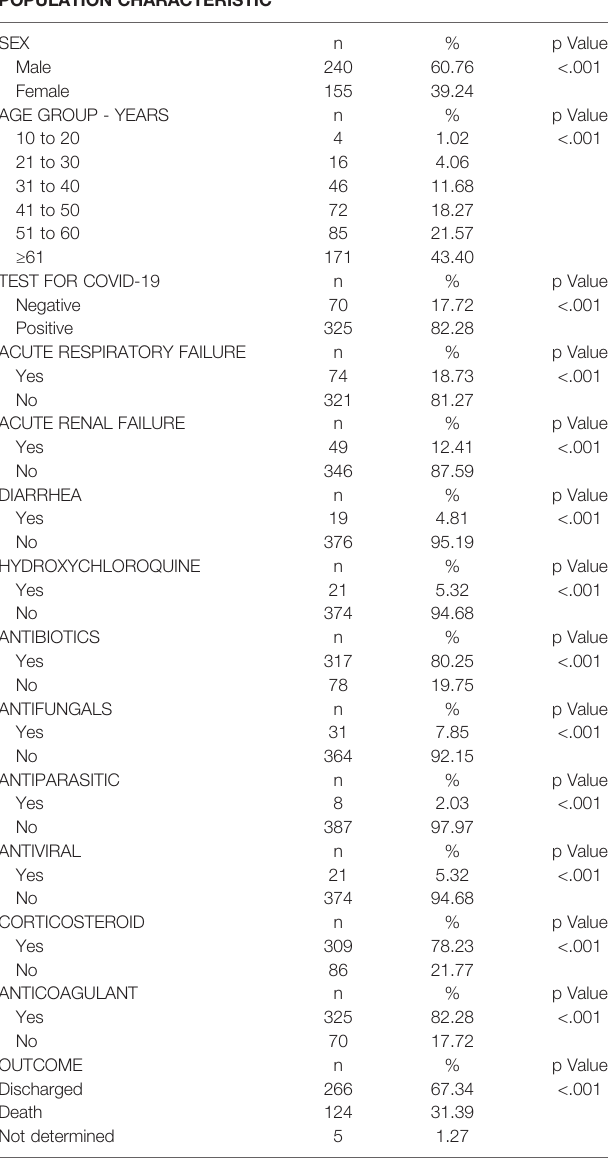
TABLE 2 | Distribution of hospitalized patients with a suspected COVID-19 diagnosis in the macroregion of the Tria ̂ ngulo Mineiro, Southeast of Brazil by sex, age group, diagnostic con fi rmation, pulmonary, renal or intestinal disorders, use of drugs, and hospitalization outcome between March and October 2020. POPULATION